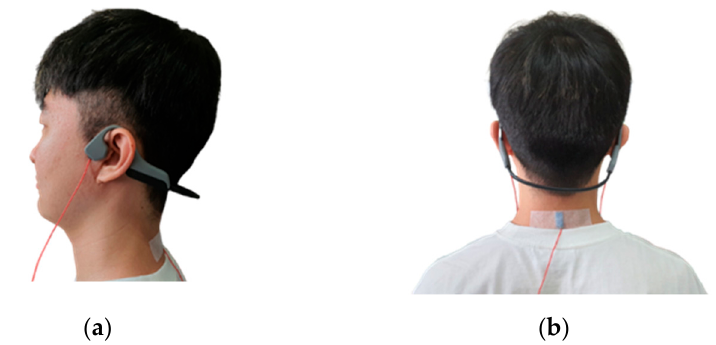
Figure 3. Positions of electrodes for EOG and EMG measurement: ( a ) side view; ( b ) rear view.